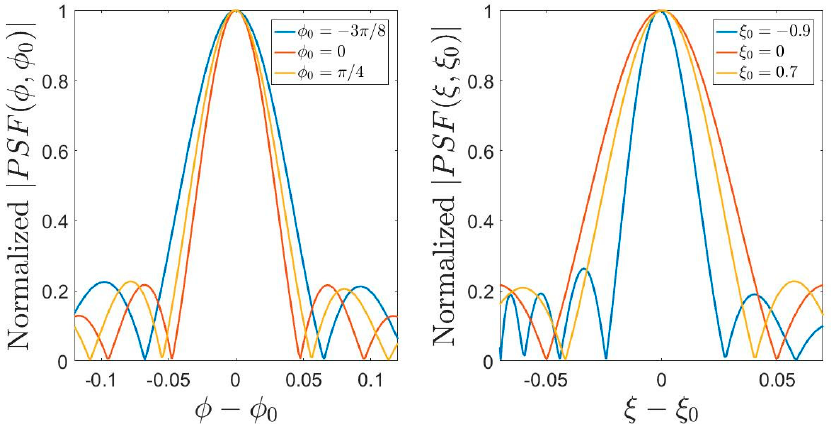
Figure 6. Normalized and overlapped PSFs of L θ (left panel) and L u (right panel) operators of a semi-circumference source with a x = 10 λ for φ 0 = − 3 π /8, 0, π /4 and for the corresponding values ξ 0 = − 0.9, 0, 0.7.